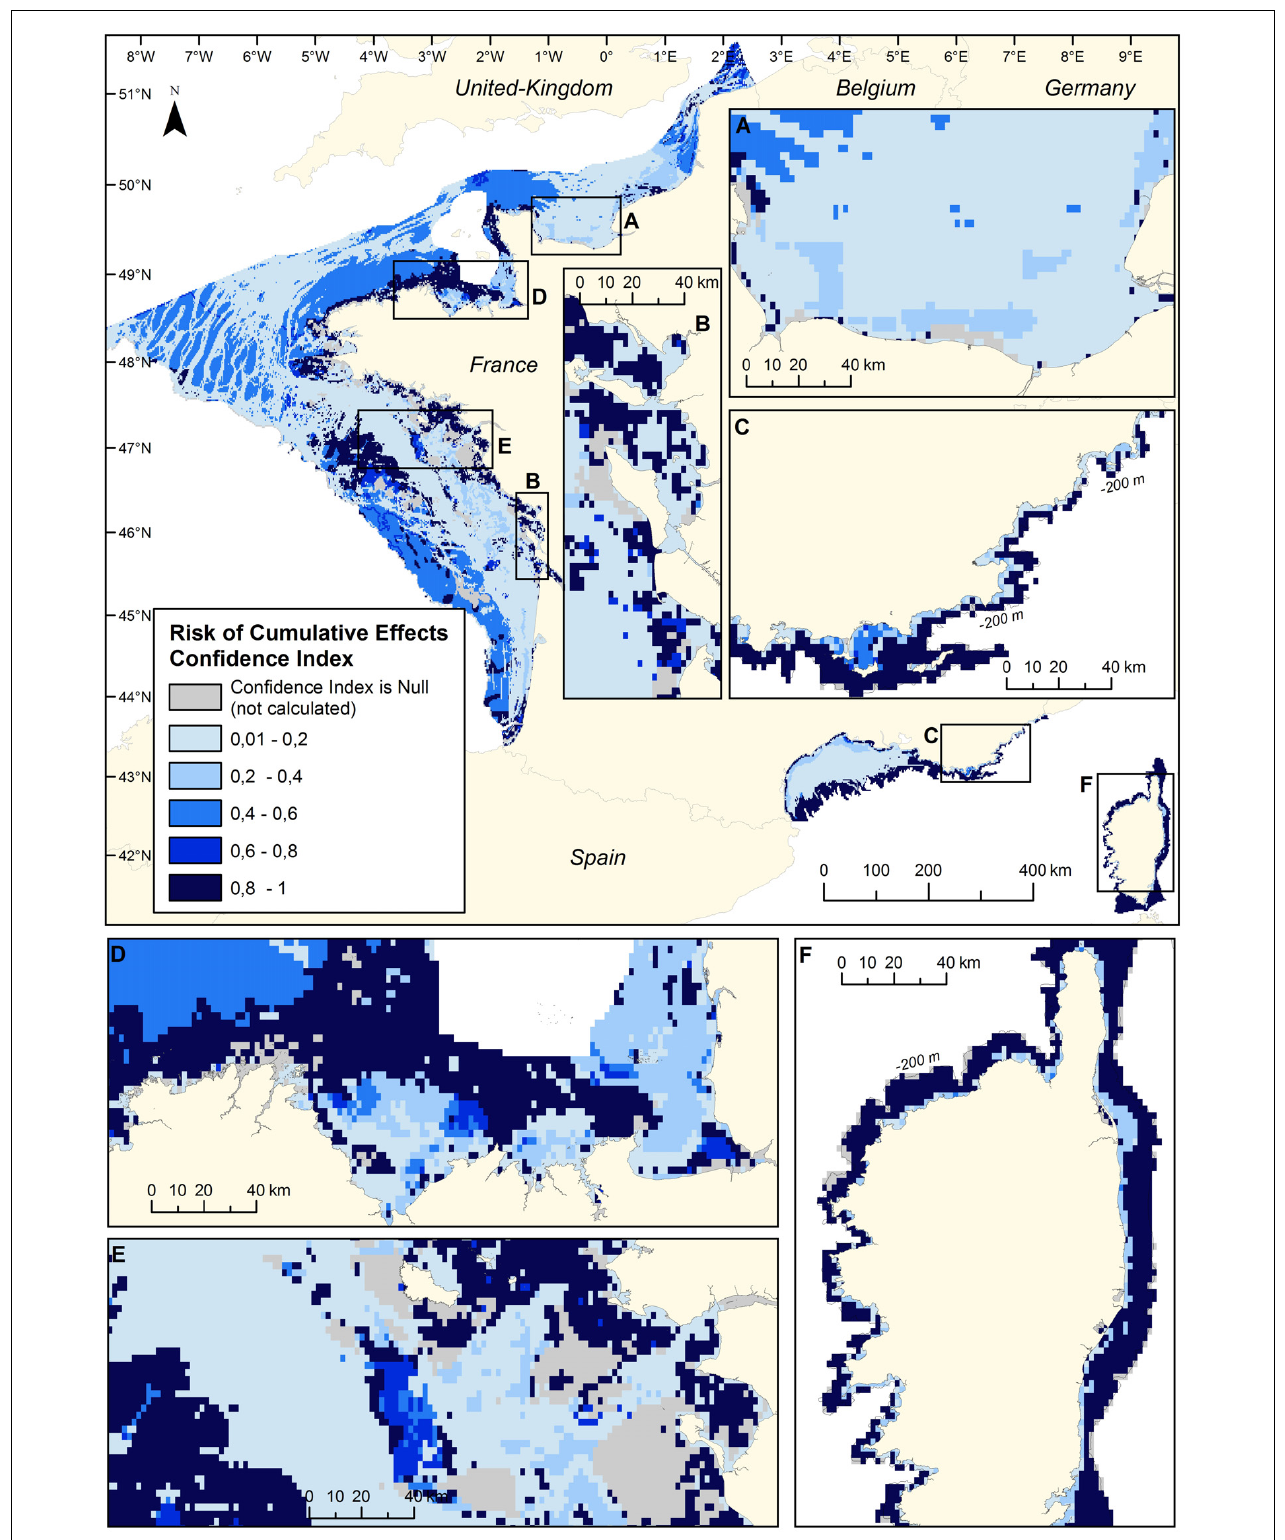
FIGURE 9 | Risk of Cumulative Effects Confidence Index map. (A) Bay of Seine, (B) Pertuis Charentais and Gironde estuary, (C) French Riviera (Côte d’Azur), (D) Normand-Breton Gulf, (E) Loire estuary, (F) Corsica.